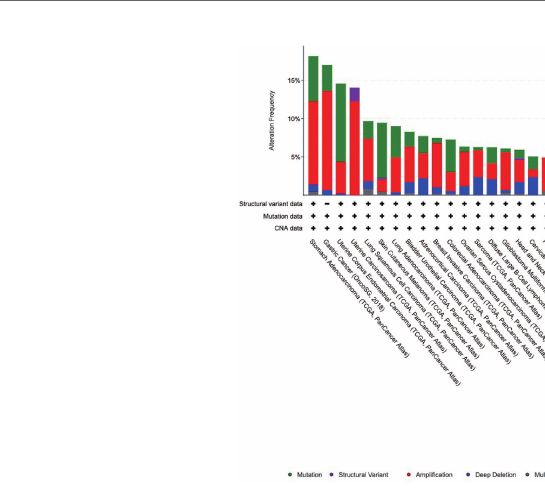
FIGURE 5 | Genetic alterations of IGFBP1 – 7 in different cancer patients from cBioPortal